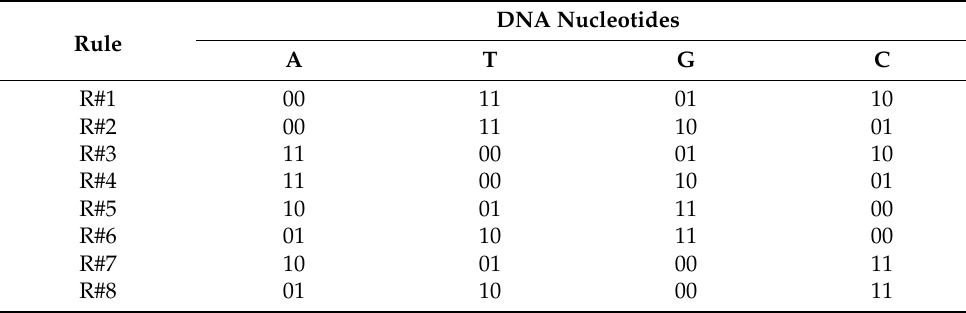
Table 1. DNA nucleotides encoding rules [47].